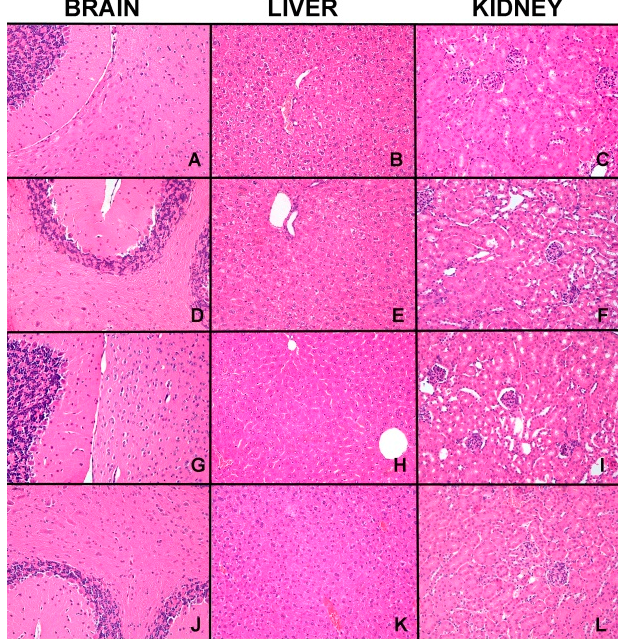
Figure 8. The figure shows representative microscopic pictures (200× magnification) of kidney, liver and central nervous system tissues of untreated mice ( A – C ); mice treated with only vehicle ( D – F ); mice treated with dose level of 50 mg/kg of Si306 ( G – I ) and mice treated with the dose level of 100 mg/kg of Si306 ( J – L ).